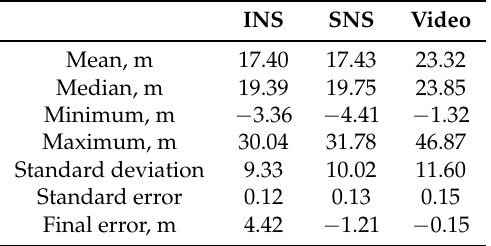
Table 2. Sample statistics of the altitude tracking error to the program